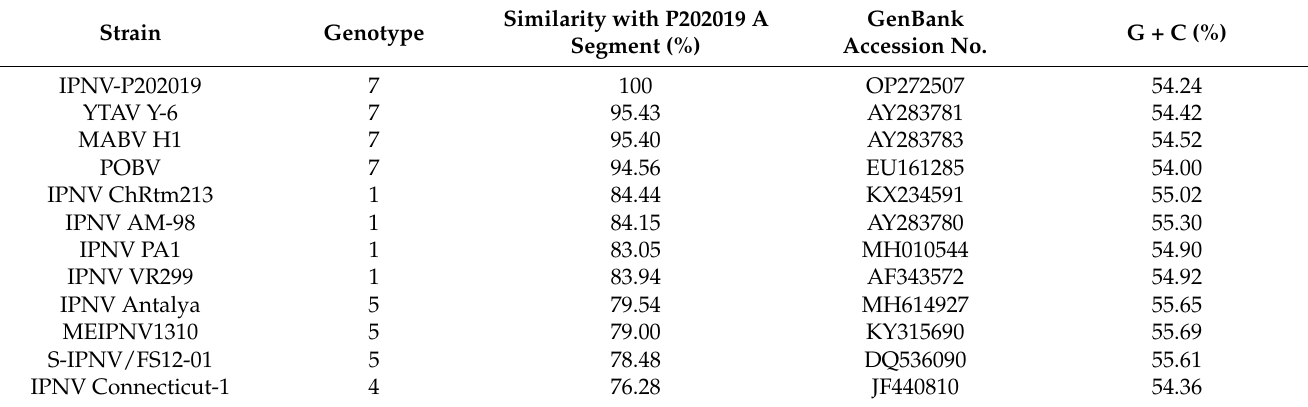
Table 1. Nucleotide identities for the full-length genome of IPNV-P202019 A segment. Similarity with P202019 A GenBank Strain Genotype Segment (%) Accession No.